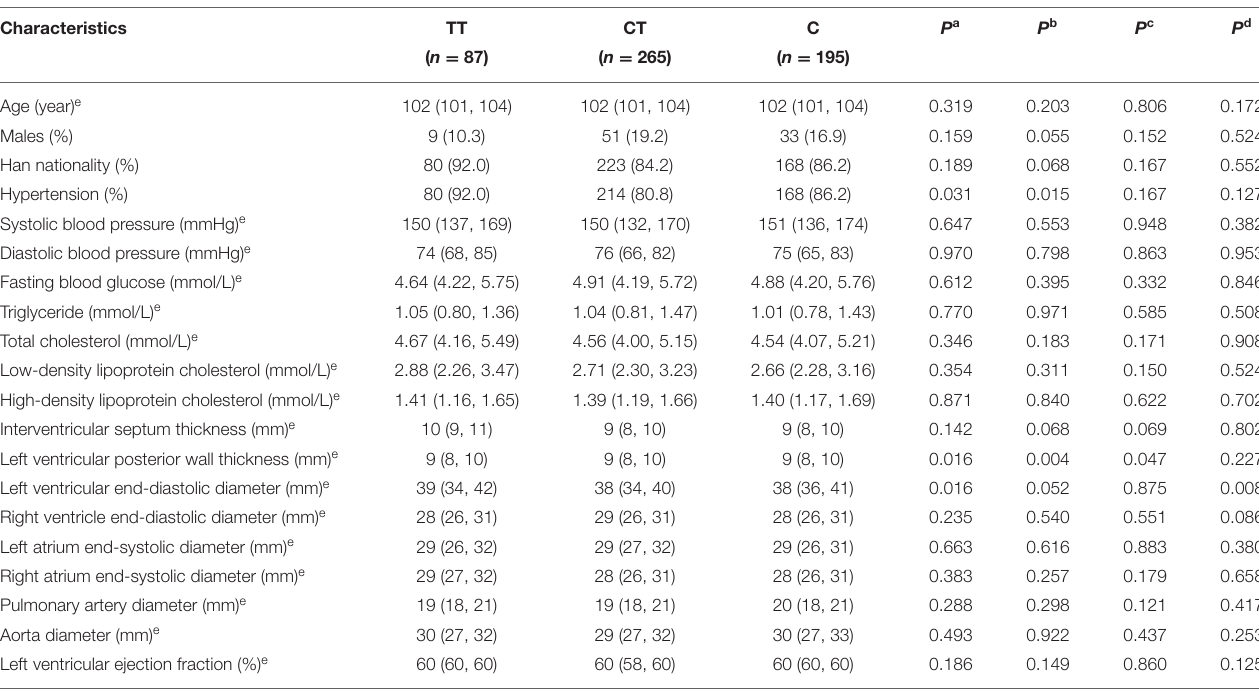
TABLE 3 | Basic characteristics of centenarians with different genotypes of rs189037.